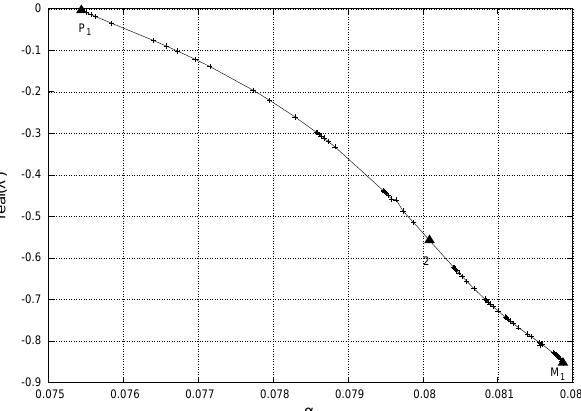
Fig.8: Leading realeigenvalue λ 0 betweenthepitchforkbifurcation P 1 andthemergingpoint M 1 ; Fig. 8. Leading real eigenvalue λ 0 between the pitchfork bifurca- point 2 isan intermediate point referredto inFig. 9b. Allthree points are marked by solidtriangles. tion P 1 and the merging point M 1 ; point 2 is an intermediate point referred to in Fig. 9b. All three points are marked by solid mode.